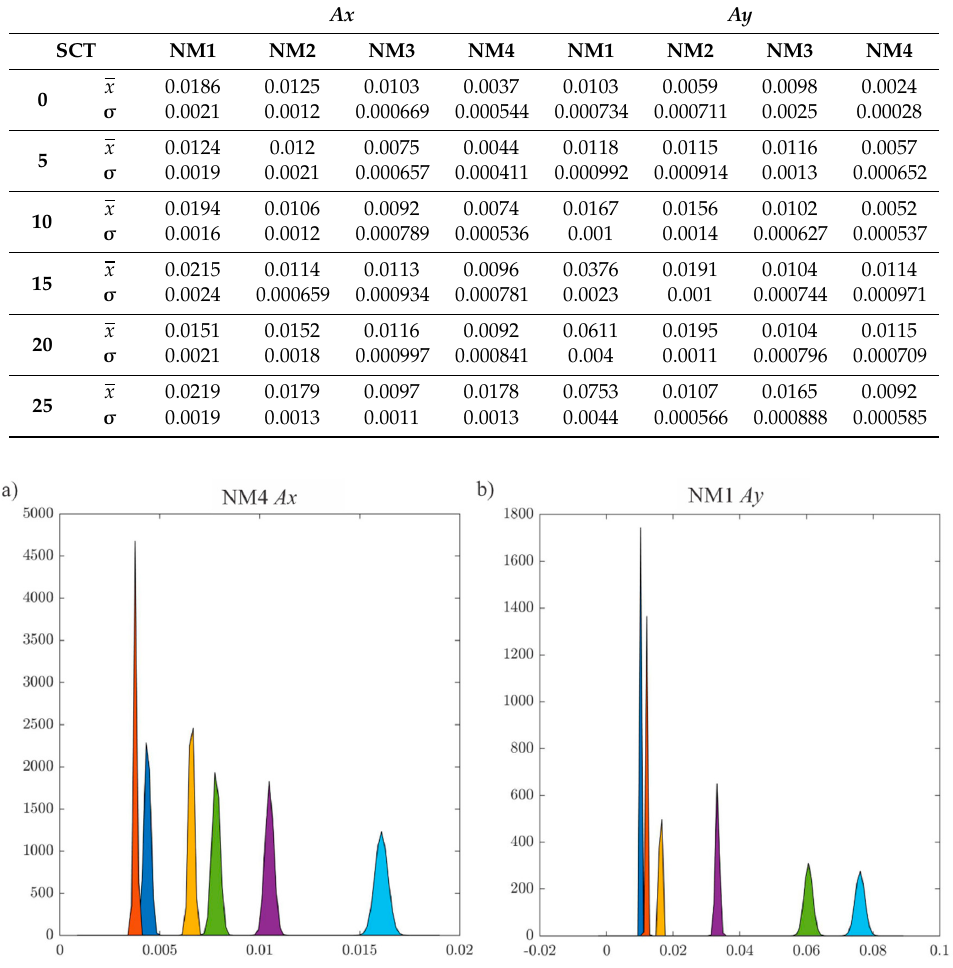
Table 1. Mean ( x ) and standard deviation ( σ ) for the RMS values. Table 1. Mean ( (cid:2206)(cid:3365) ) and standard deviation ( σ ) for the RMS values. Table 1. Mean ( (cid:2206)(cid:3365) ) and standard deviation ( σ ) for the RMS values. Ax Ay